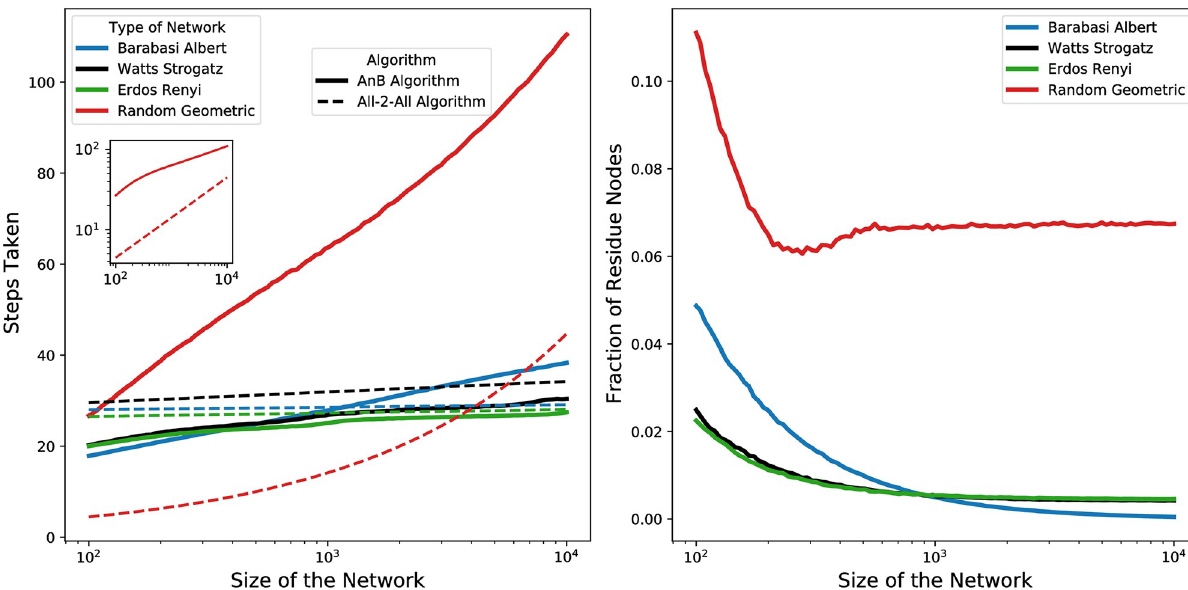
Fig 3. Numerically estimated time costs of the AnB algorithm. The left panel shows, on a log-linear scale, the total number of iterative steps taken by the AnB algorithm for different random networks (solid lines). The dashed lines show the scaling of the time for the All-2-All method, which corresponds to the network diameter D from Table 3. The diameter is known up to a scaling factor, here we report curves scaled to values comparable to AnB’s execution time to ease the comparison. In fact, the intersection of same-colour curves indicates that for large networks, the AnB algorithm is asymptotically slower than the All-2-All method. This is the case for all the analyzed network topologies but the Random Geometric networks. In RG networks, All-2-All shows a steeper curve that would slow down the process for very large networks (see inset on a log-log scale). The right panel shows the fraction of residue nodes x ¼ r in the network. Low x implies low r and hence better performance of AnB algorithm in terms of memory and N communications cost (see Table 2). For each network size, we report the average results for the simulation of 1,000 independent random networks. (95% confidence intervals are reported in the left panel as shades but often are smaller than the line